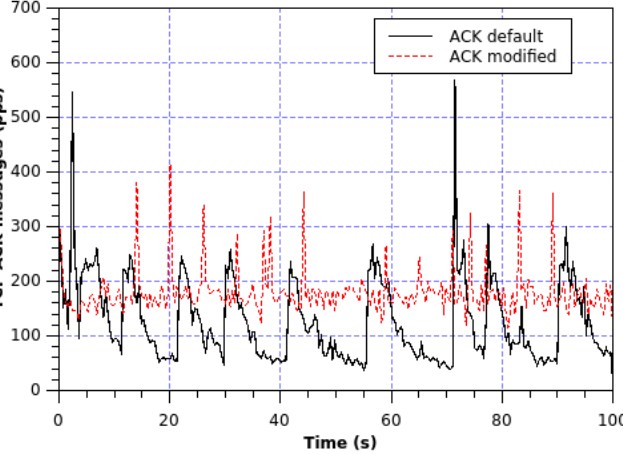
Figure 17. Comparison of ACK transmission between a modified and an unmodified Linux